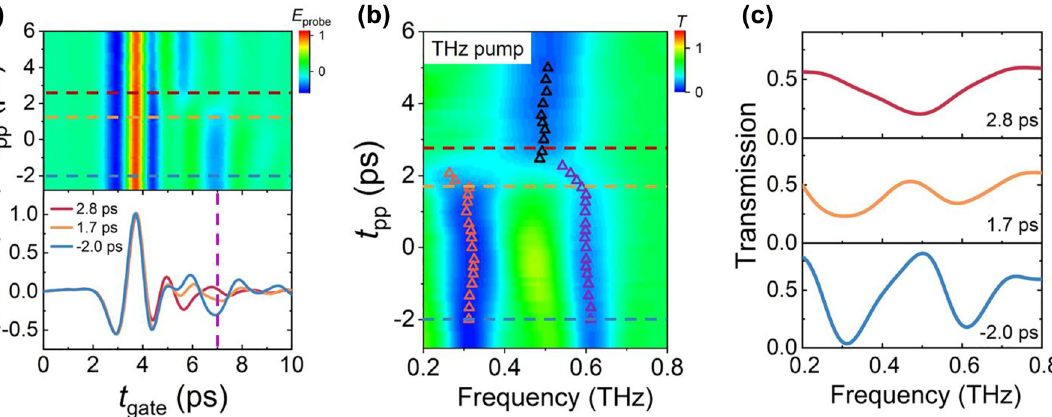
Figure 3: Ultrafast mode switching triggered by intense THz pump pulse. Two-dimensional plot of the transmitted THz pulse profile (a) and spectra (b) as a function of t when the E is 25 kV/cm. The resonance frequencies are marked with triangles. (c) THz transmission spectra at pp 0 t pp = − 2.0, 1.7, and 2.8 ps corresponding to dashed lines marked in (a) and